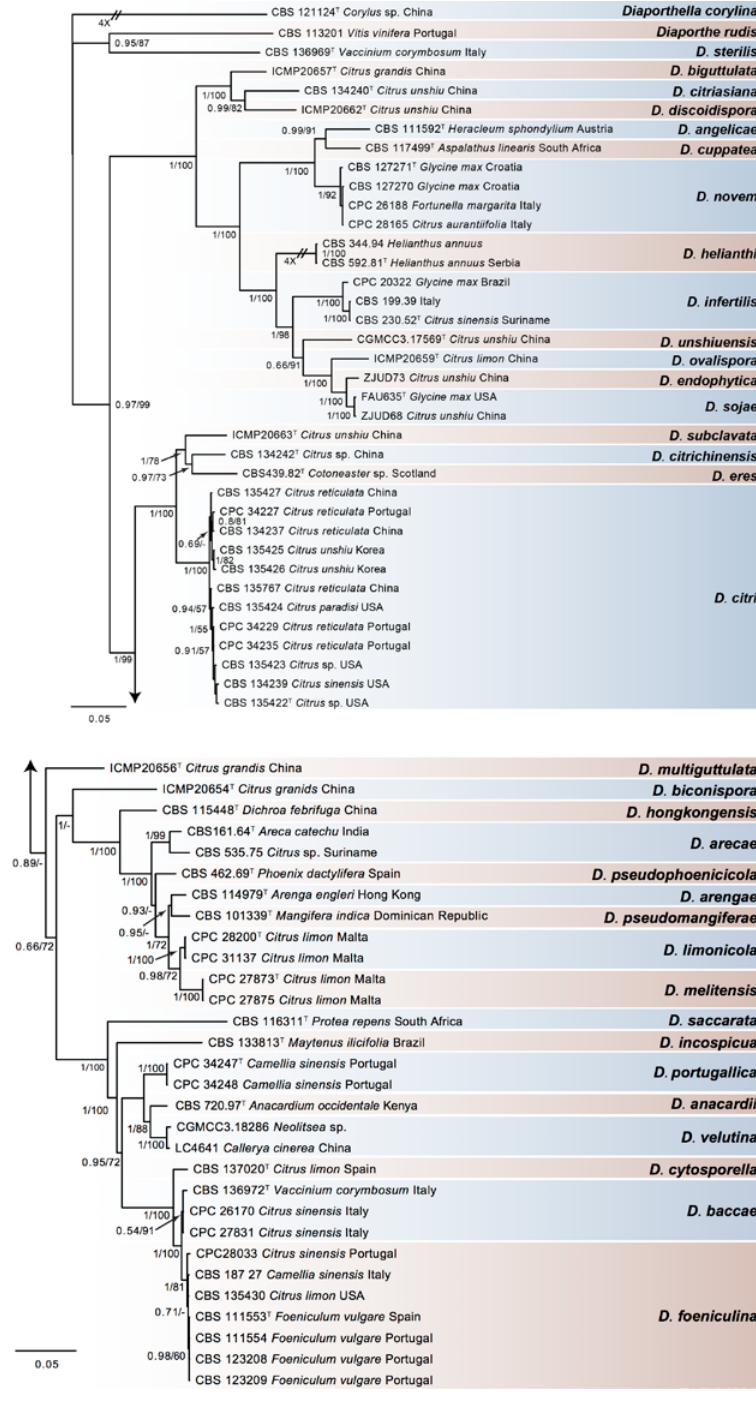
Figure 2. Consensus phylogram of 1,042 trees resulting from a Bayesian analysis of the combined ITS, tub2 , his3 , tef1 and cal sequences. Bootstrap support values and Bayesian posterior probability values are indicated at the nodes. Substrate and country of origin are listed next to the strain numbers. T indicates ex-type strains. The tree was rooted to Diaporthella corylina (CBS